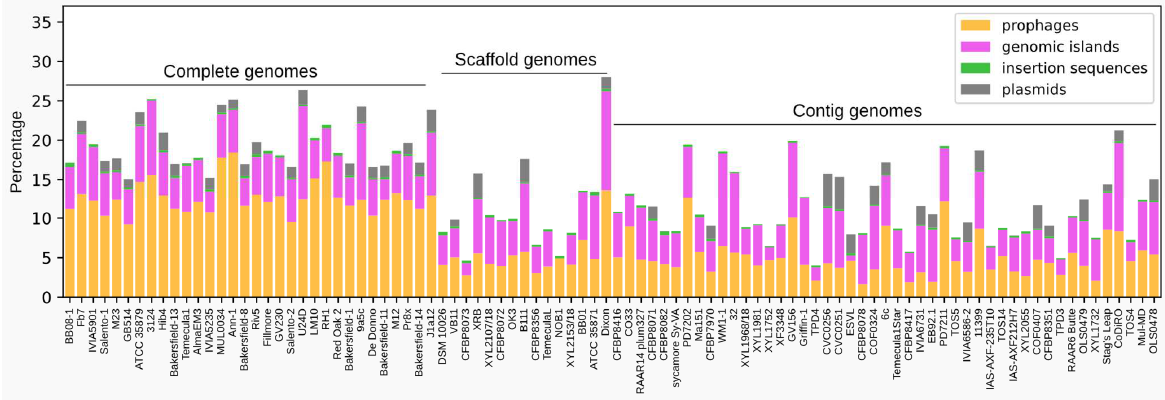
Figure 4. Percentage of mobile genetics elements distributed among the X. fastidiosa strains according to their genome assembly status: complete, scaffold and contig.